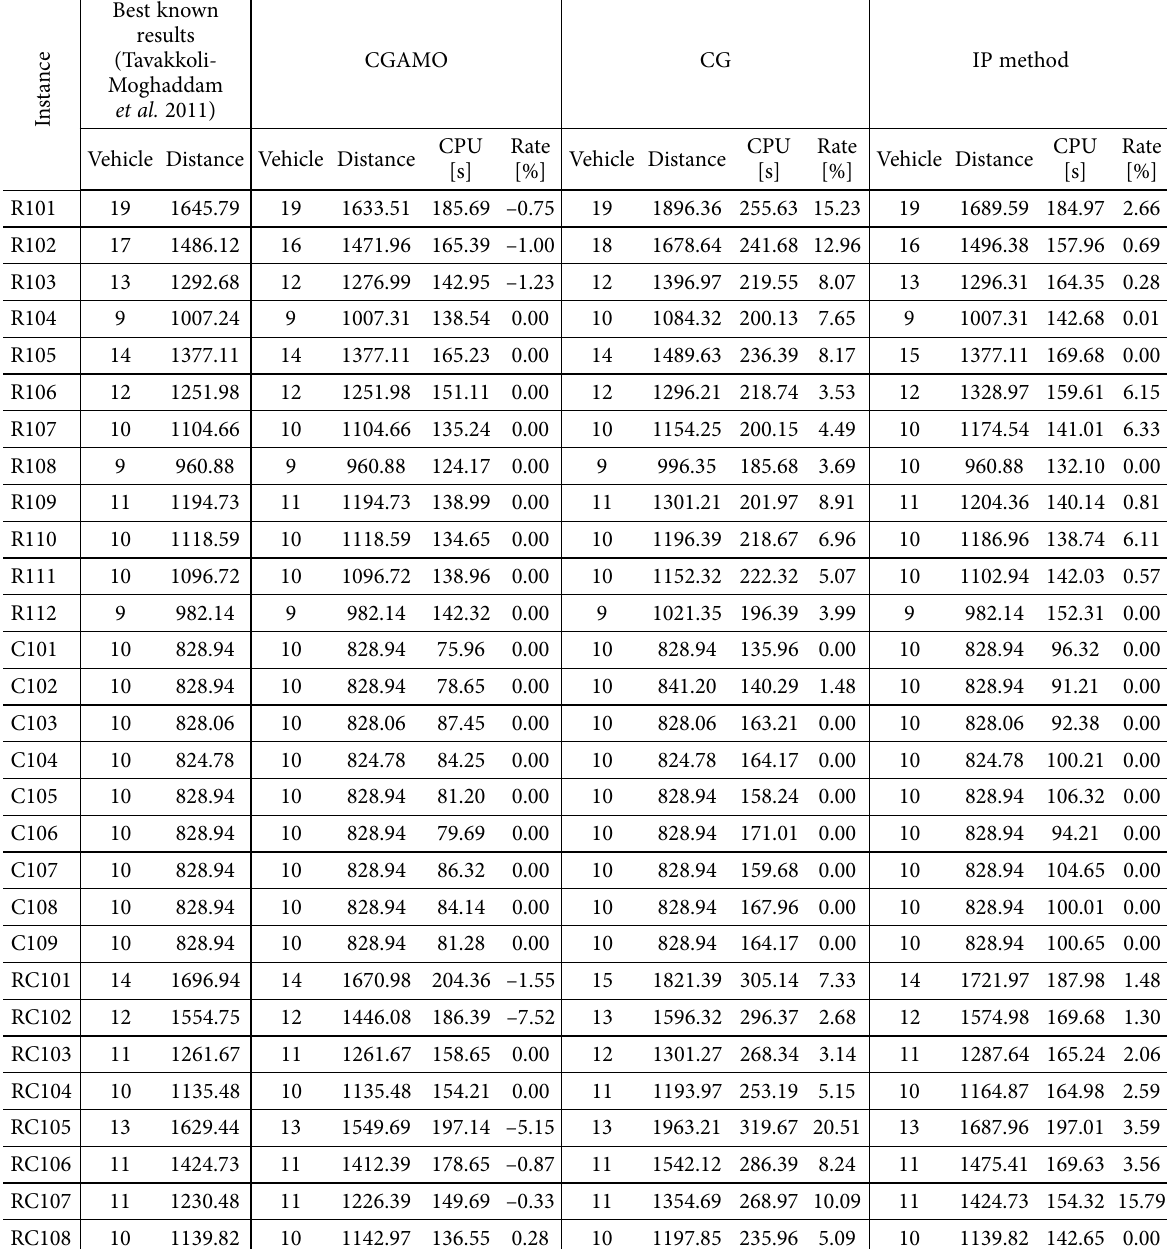
Table 1. Comparison of the performance of the CGAMO, CG and IP